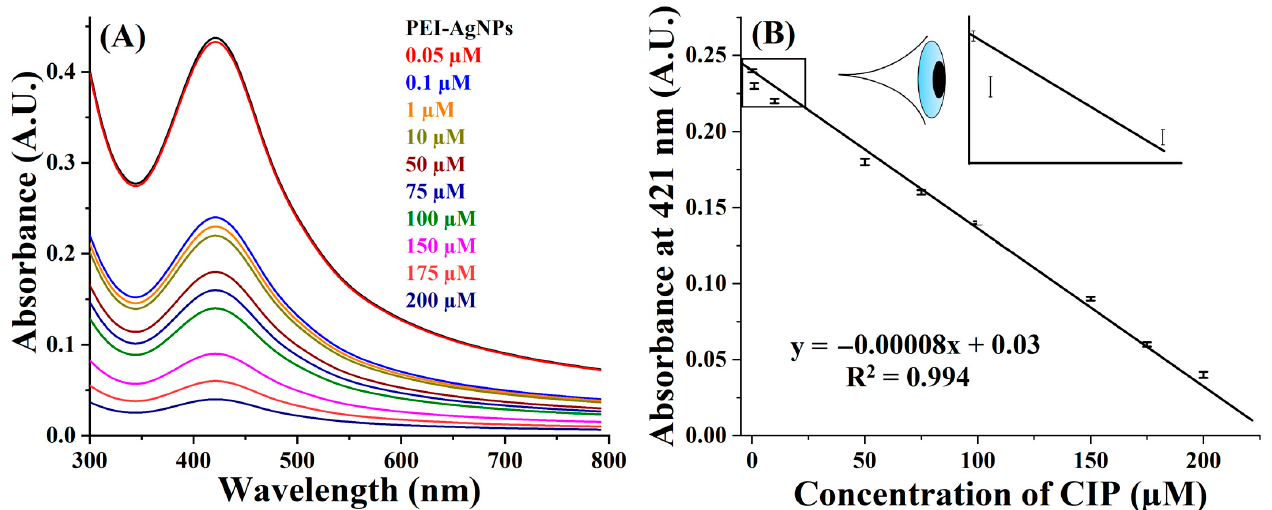
Figure 5. ( A ) UV-visible spectra of PEI-AgNPs alone and after adding different concentrations of CIP in PEI-AgNPs ( B ) plot of absorbance versus different concentrations of CIP ranging from 0.1– 200 µM, inset shows a magnified view of the concentration dependence of absorbance in the range of 0.1–10 µM. range of 0.1–10 µ